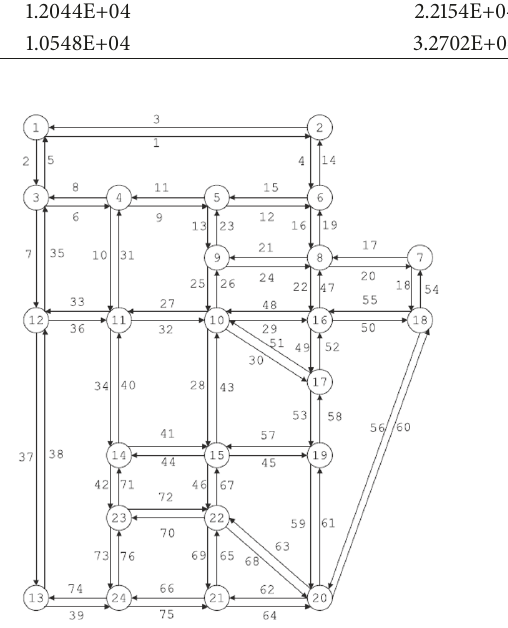
Figure 3: Sioux-Falls